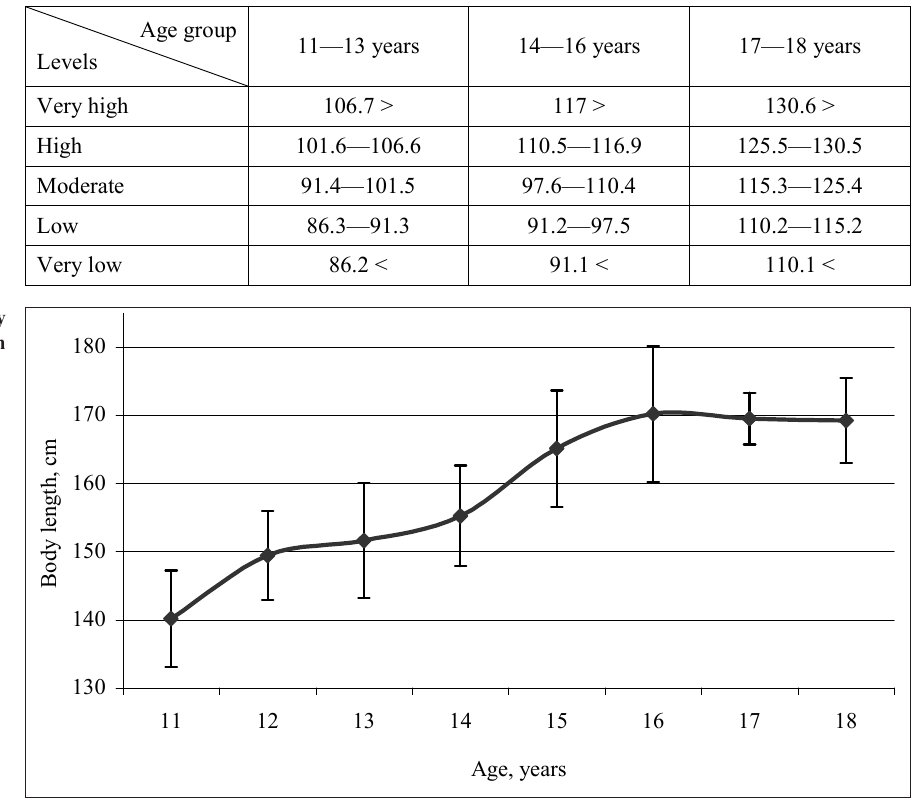
Table. Estimation of general work capacity of young Greco-Roman wrestlers